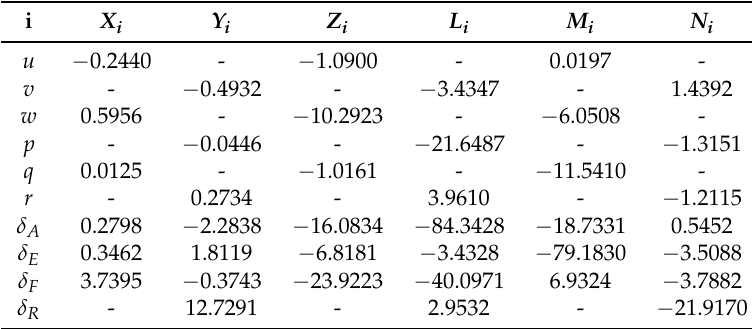
Table 3. Parameters estimated from multi-step experiments.